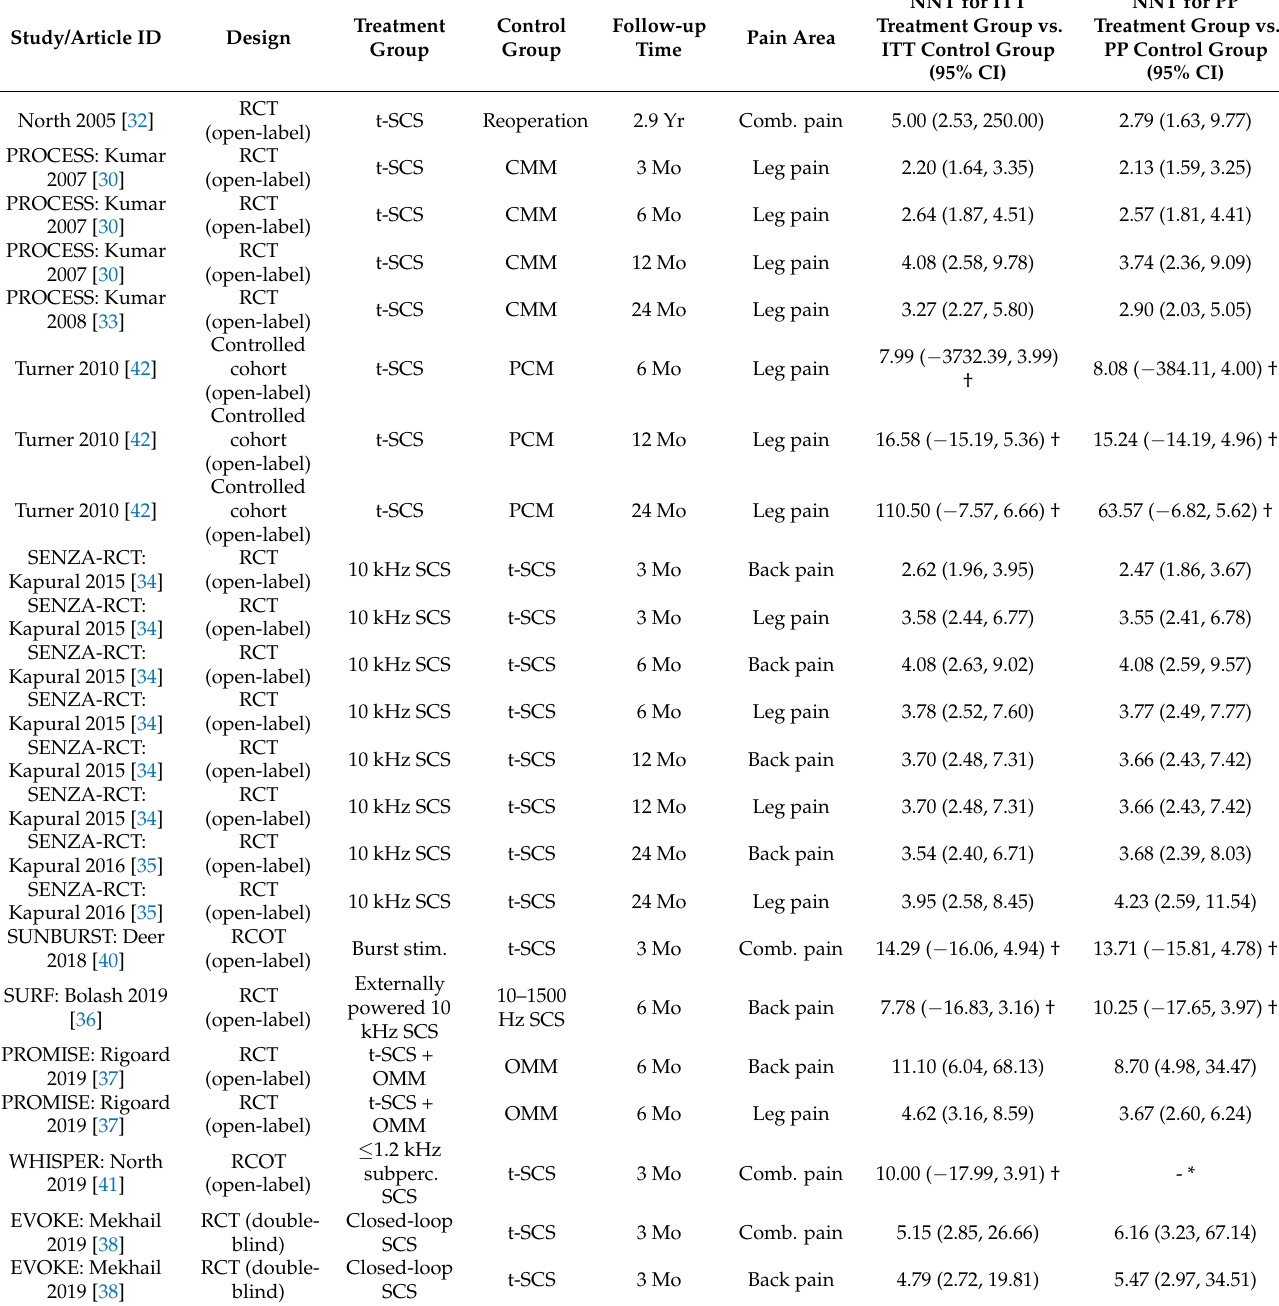
Table 2. NNT with 95% CI for SCS controlled trial ITT and PP